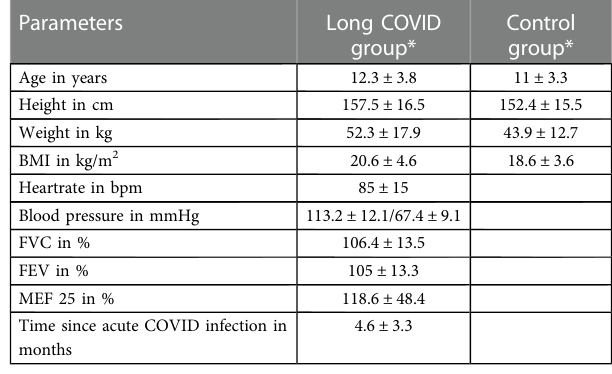
TABLE 1 Clinical and descriptive data of the participants in the study and control